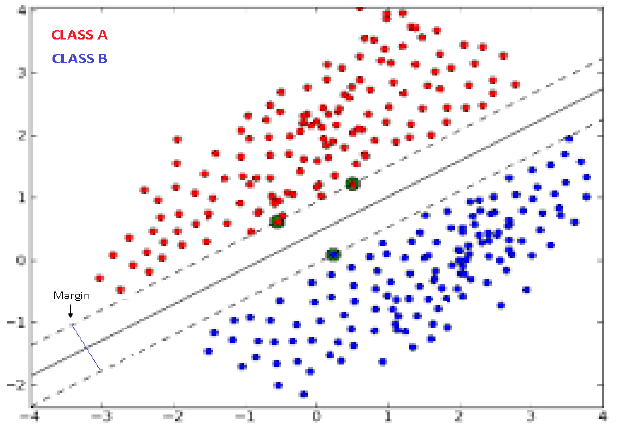
Figure 1. Maximum margin hyper-plane for SVM with samples from two